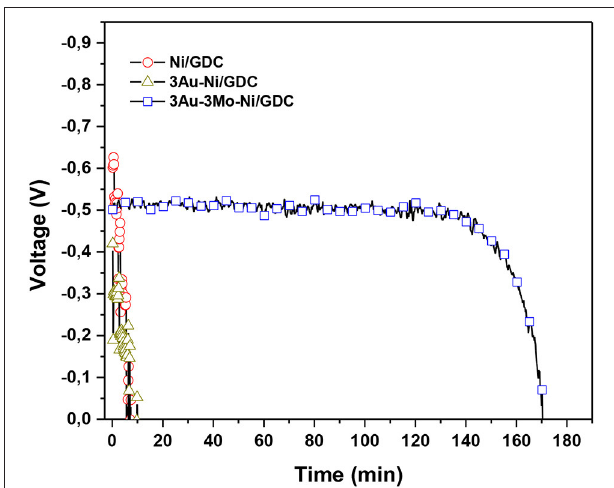
FIGURE 19 | Stability diagrams of blank and Au-Mo modified Ni/GDC anodes under CH 4 steam reforming conditions (S/C = 2) plus 10 ppm H 2 S. The experiments were performed at T = 850 0 C, j = 28 mA/cm 2 and F total = 100 cc/min. The reaction feed comprised, 6 vol.% H 2 O, 3 vol.% CH 4, and 10 ppm H 2 S in helium. Reprinted with permission from Neofytidis et al.